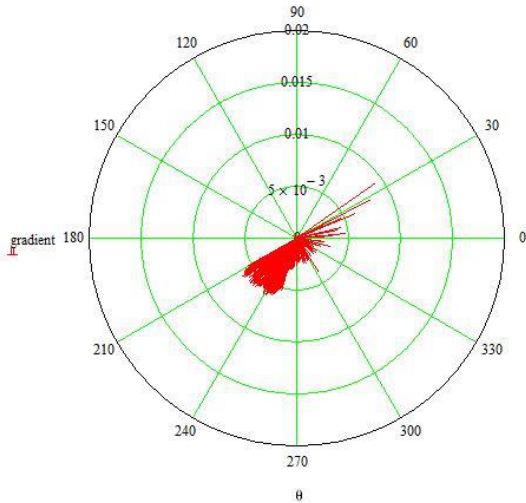
Figure 5. Rose chart for hydraulic gradients vs. angles at PCD, CO.